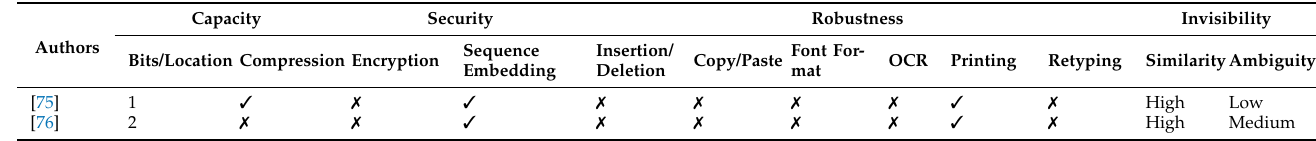
Table 20. Evaluation of dot method based on invisibility and robustness and capacity.